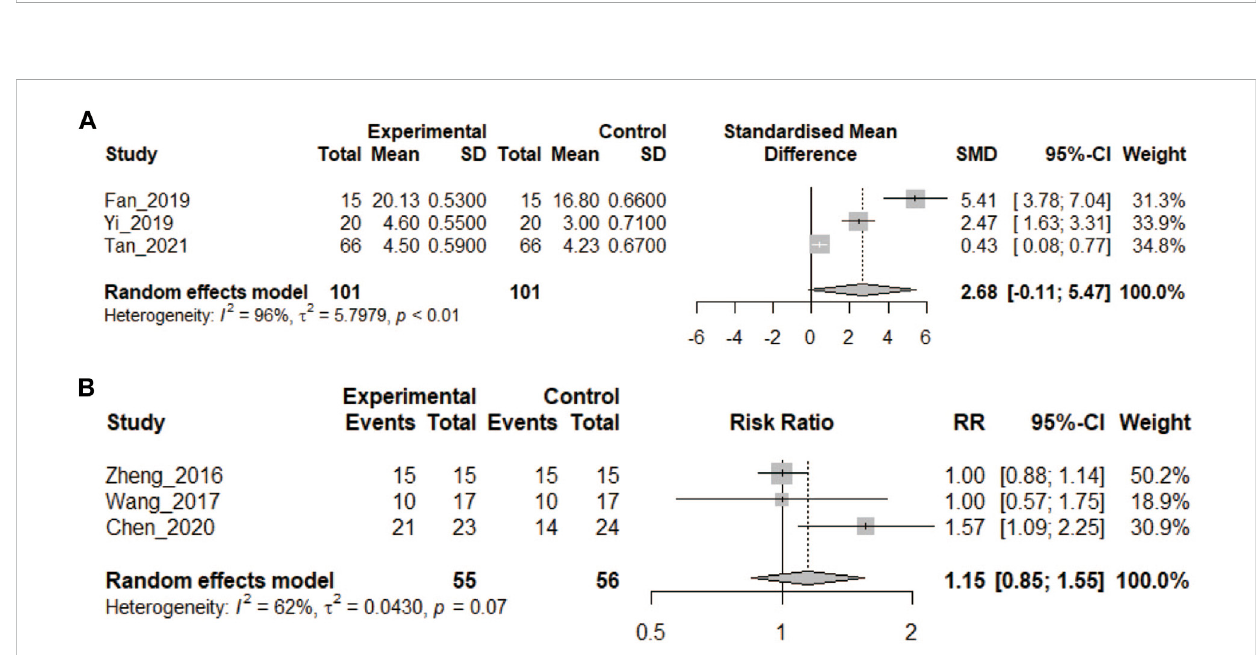
FIGURE 7 (A) In the comparative study of 3DPs vs. control, the continuous variable data were combined to compare the post training satisfaction of the two groups. (B) In the comparative study of 3DP vs. control, the binary variable data were combined to compare the satisfaction of the two groups after